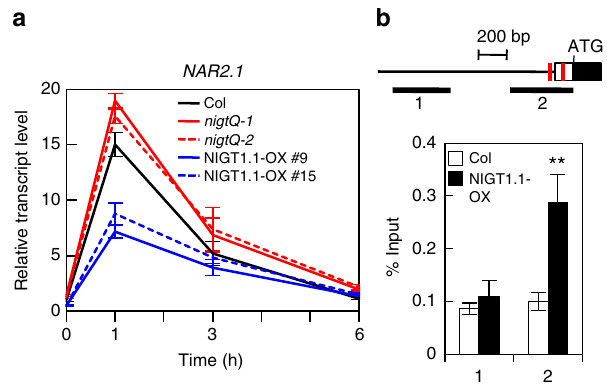
Fig. 4 Repression of NAR2 . 1 by NIGT1s. a Time-dependent expression of NAR2 . 1 in Arabidopsis Col, nigt1 quadruple mutants ( Q-1 and Q-2 ), and two NIGT1.1-OX lines (#9 and #15). Seedlings were harvested at the indicated time points after supply of 10 mM KNO 3 . Values are normalised with expression levels of UBQ10 , and means of biological triplicates ± s.d. are shown. b Binding of NIGT1.1 to the NAR2 . 1 promoter in vivo. ChIP analysis was carried out with Col and NIGT1.1-OX seedlings. Two different regions of the NAR2 . 1 promoter that contained or did not contain putative NIGT1- recognition sequences (red bars) were ampli fi ed from immunoprecipitated DNA by PCR. Data are means of four biological replicates with s.d. ** p < 0.01 by one-tailed t -test compared with corresponding values obtained